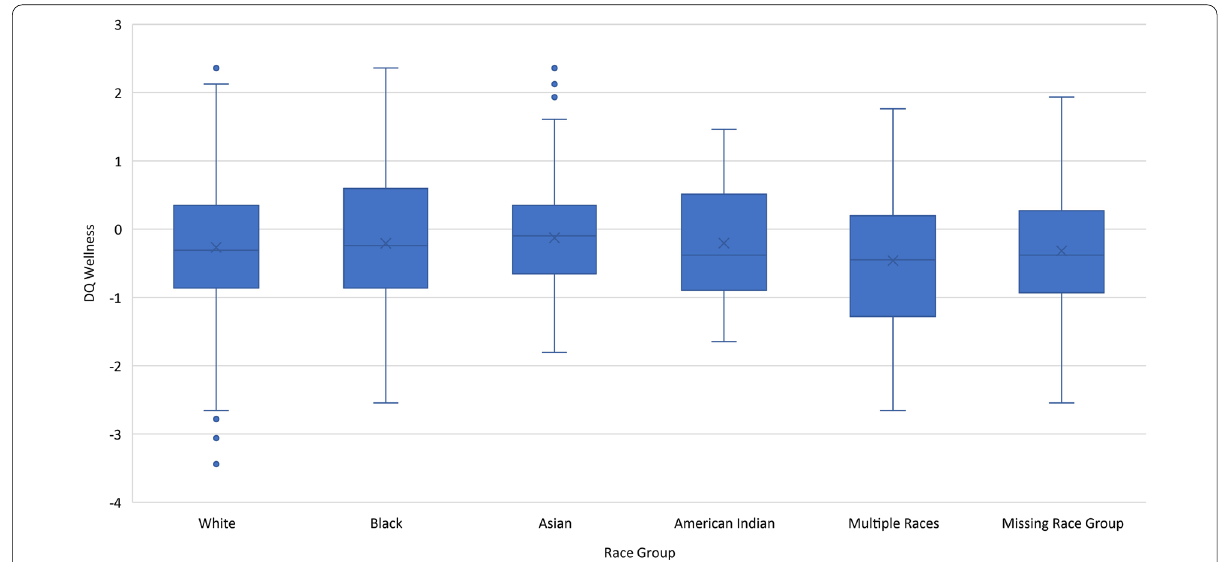
Fig. 1 Box and whisker plot showing means and 95% confidence intervals of DQ Wellness scores by race group. Although on average, all participants had negative DQ Wellness scores indicating poor levels of wellness, those with the worst scores were those endorsing multiple